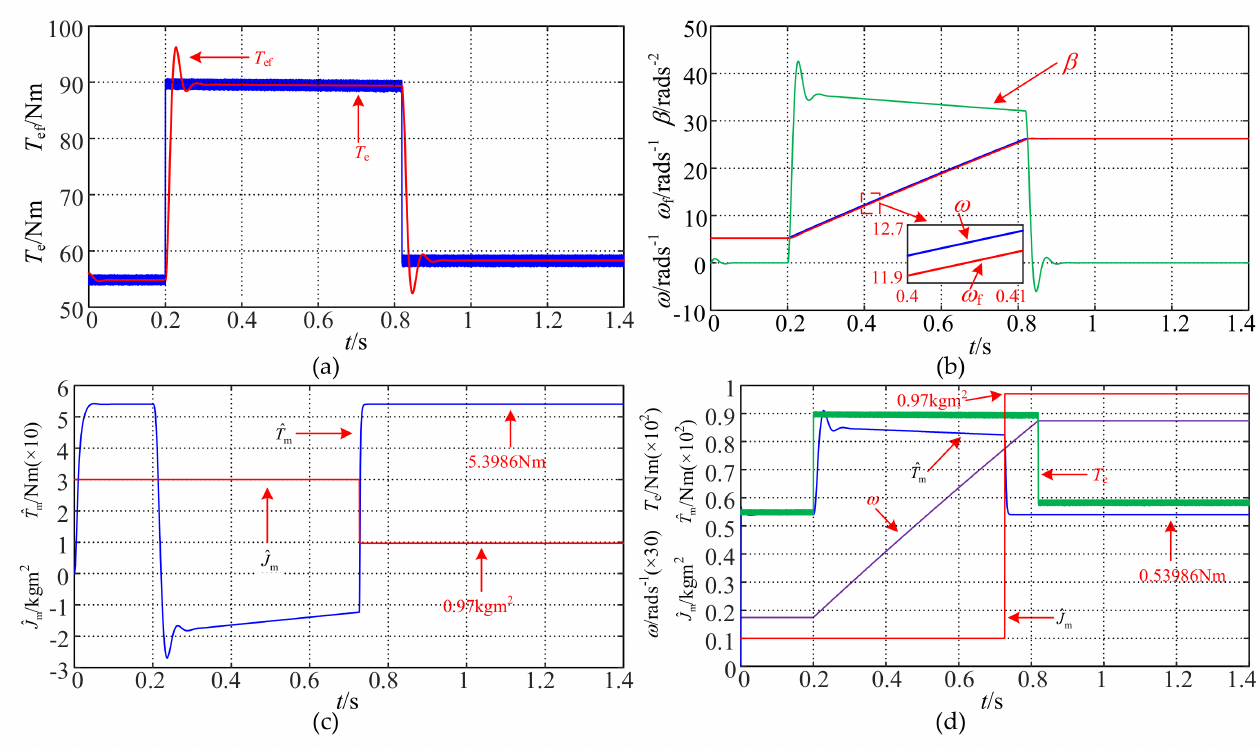
Figure 7. Simulation results: ( a ) Electromagnetic torque waveform when J m (0) = 3 kg m 2 ; ( b ) Waveform of angular velocity and angular acceleration when J m (0) = 3 kg m 2 ; ( c ) Identification waveforms of moment of inertia and total load torque when J m (0) = 3 kg m 2 ; ( d ) Simulation and identification waveform when J m (0) = 3 kg m 2.